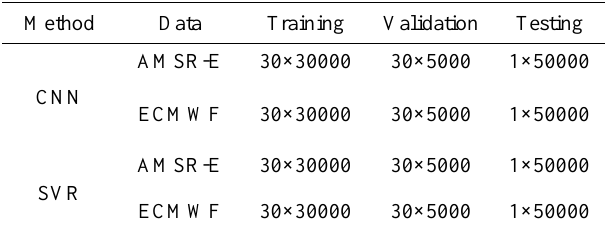
Table 1. The samples used in this